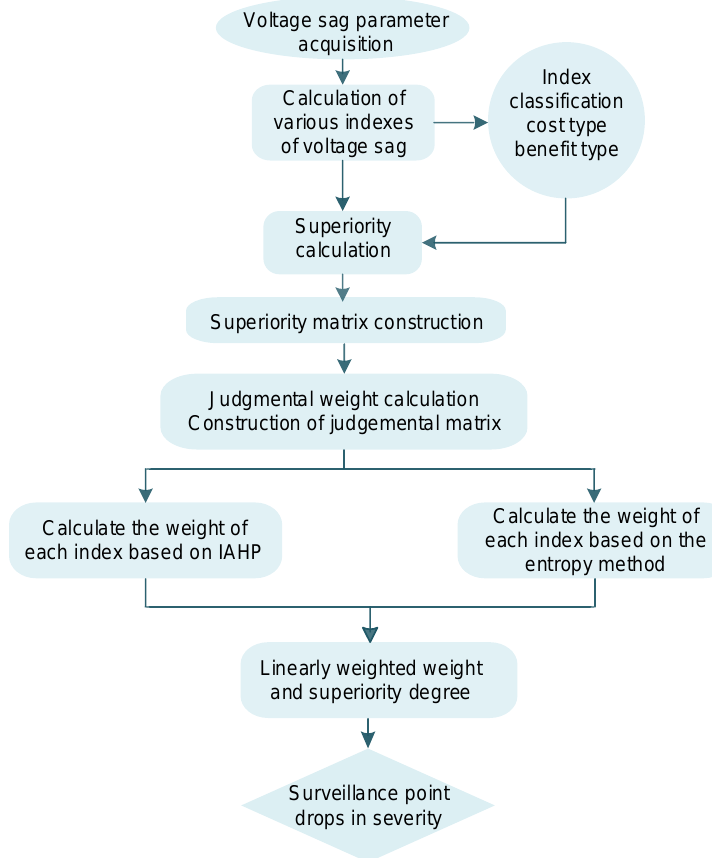
Figure 4. Flow chart of voltage sag severity calculation.